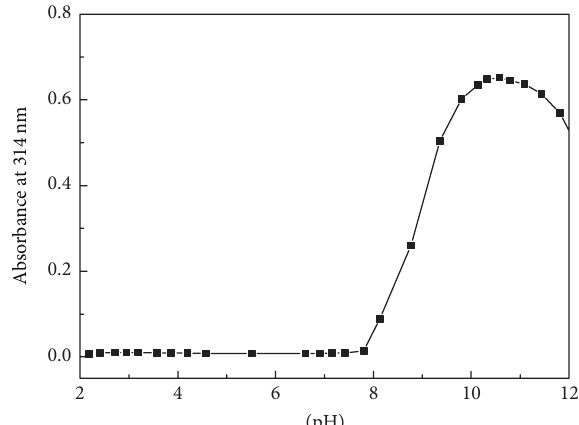
Figure 2: A -pH curve of the oxygenated DABA-Co(II) complex